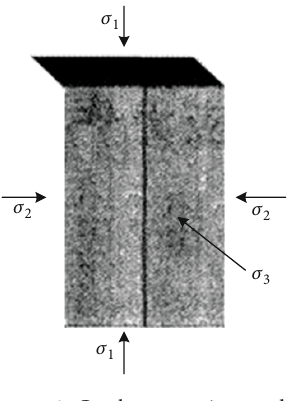
Figure 8: Crack permeation